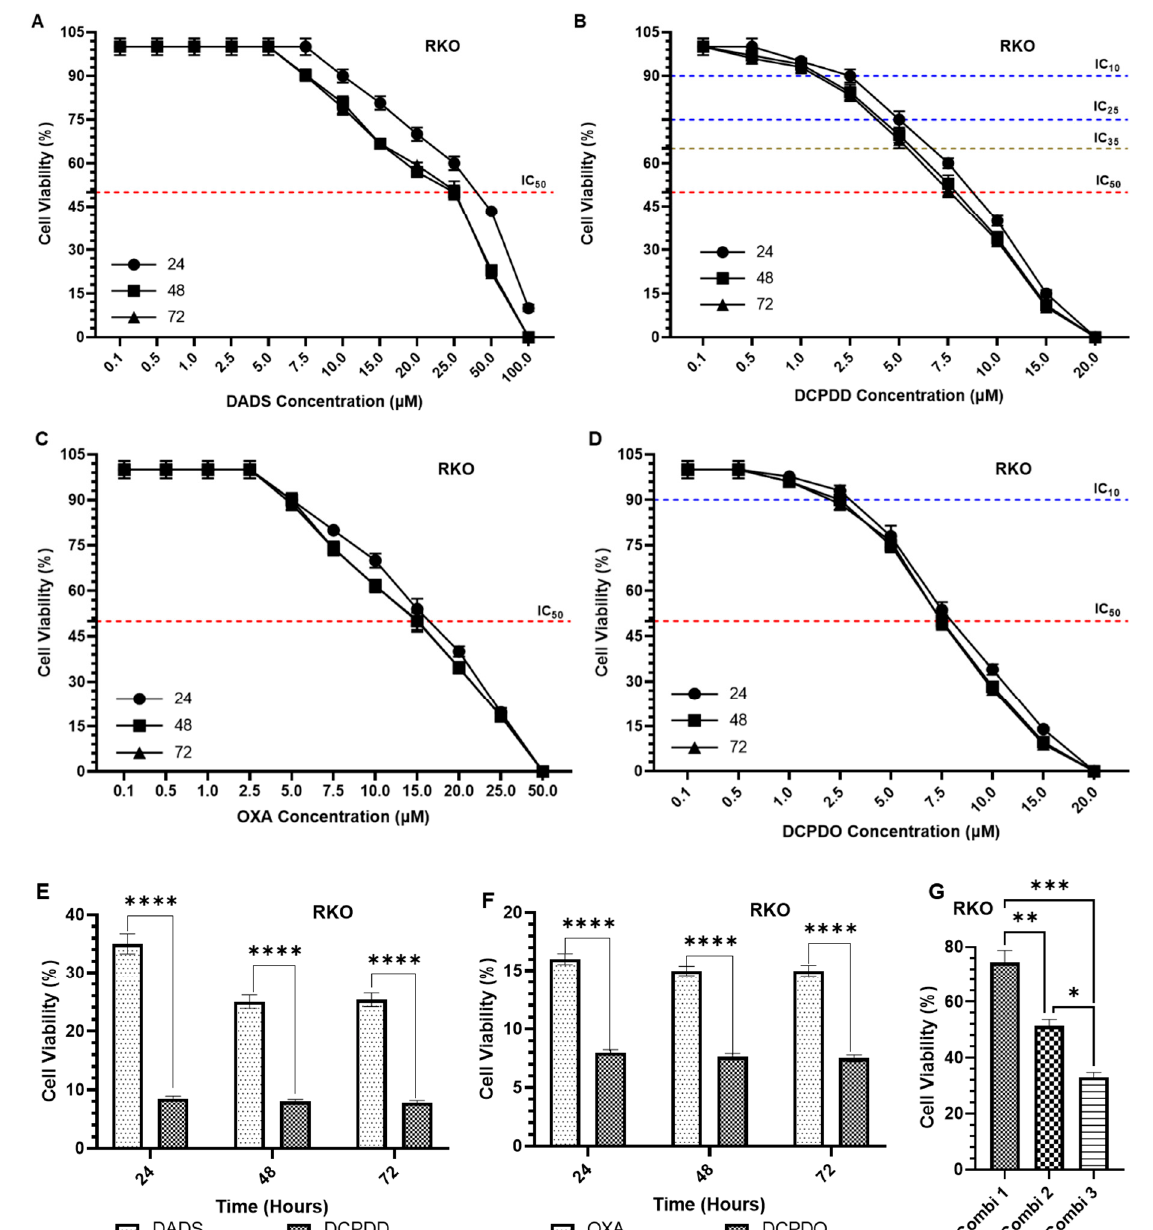
Figure 5. Effect of DADS, DCPDD, OXA, and DCPDO at varying concentrations on cellular prolif- eration by cell cytotoxicity assay at 24 h, 48 h, and 72 h in HCT116 colon cancer cells ( A ), DADS ( B ), DCPDD, ( C ) OXA, ( D ) DCPDO, ( E ) IC 50 of DADS and DCPDD, ( F ) IC 50 of OXA and DCPDO, ( G ) and cell Viability by combinations of DCPDD and DCPDO. The values are expressed as mean ± SE of three independent experiments. ** Significant difference between the treated groups, p -value < 0.01, **** Significant difference between the treated groups, p -value < 0.0001.